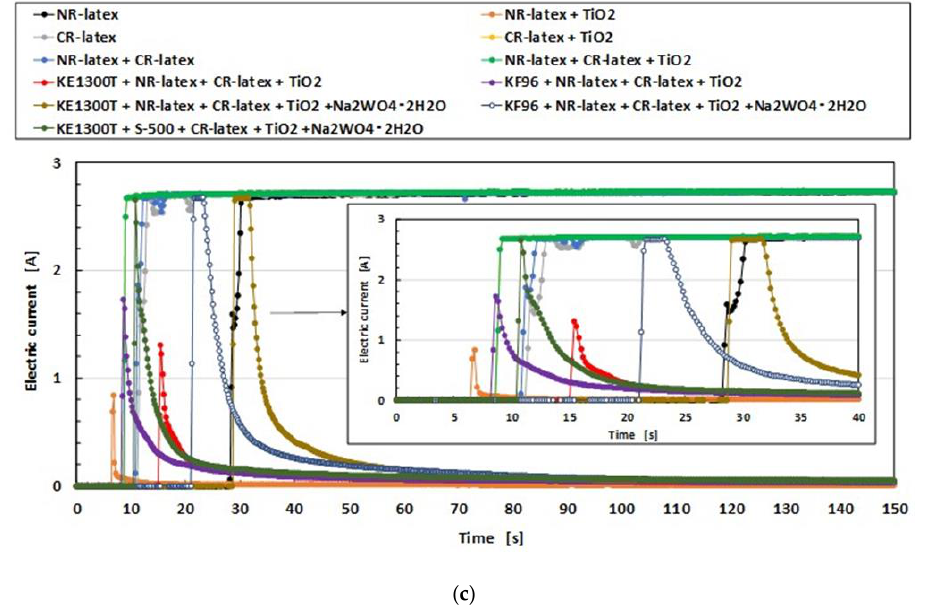
Figure A7. Changes of temperature, voltage and electric current with time via electrolytic polymerization; ( a ) temperature; ( b ) voltage; ( c ) electric current.